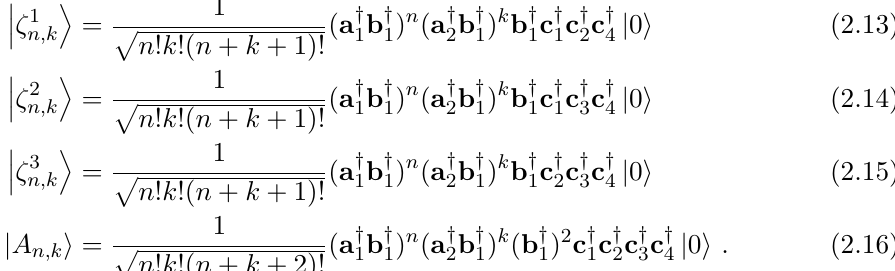
Figure 2 . The actions by the supercharges S † The blue, green and red arrows refer to the generators S † represented by inverse arrows. We can think of the diagram as a cube with 8 nodes and 12